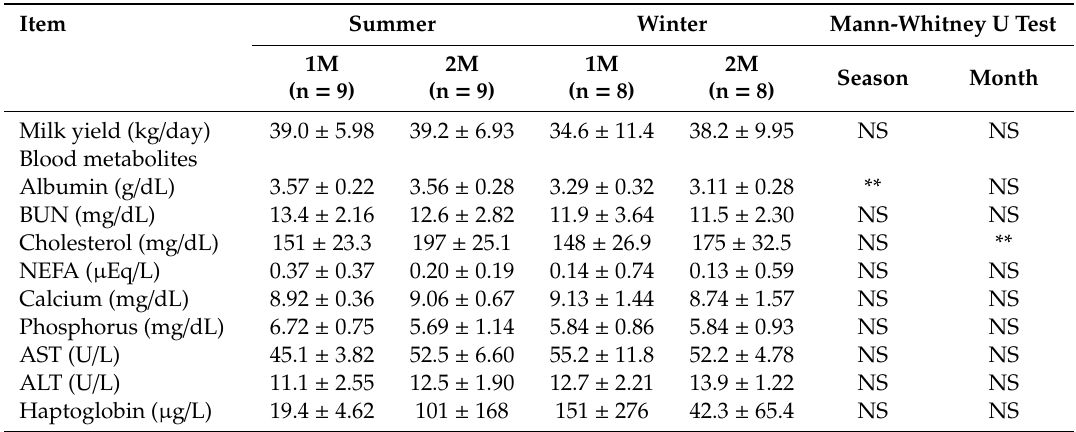
Table 1. Milk yield and blood metabolites concentration of dairy cows examined at one and two months postpartum during the two